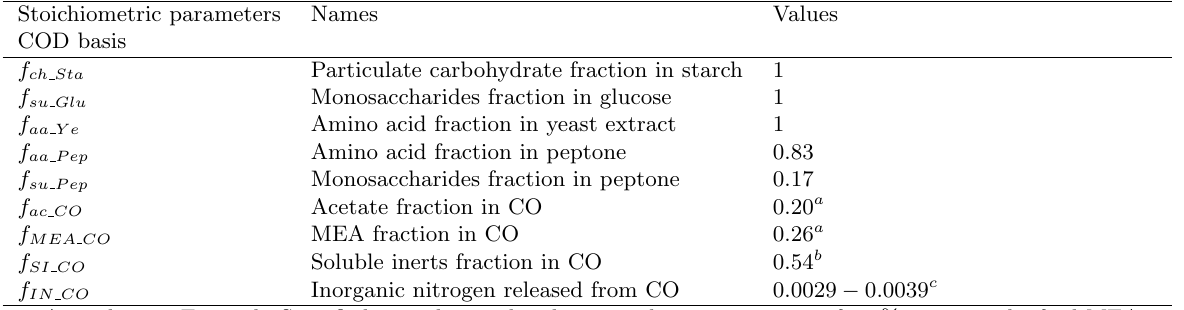
Table 1: Characterizations of the feed organics